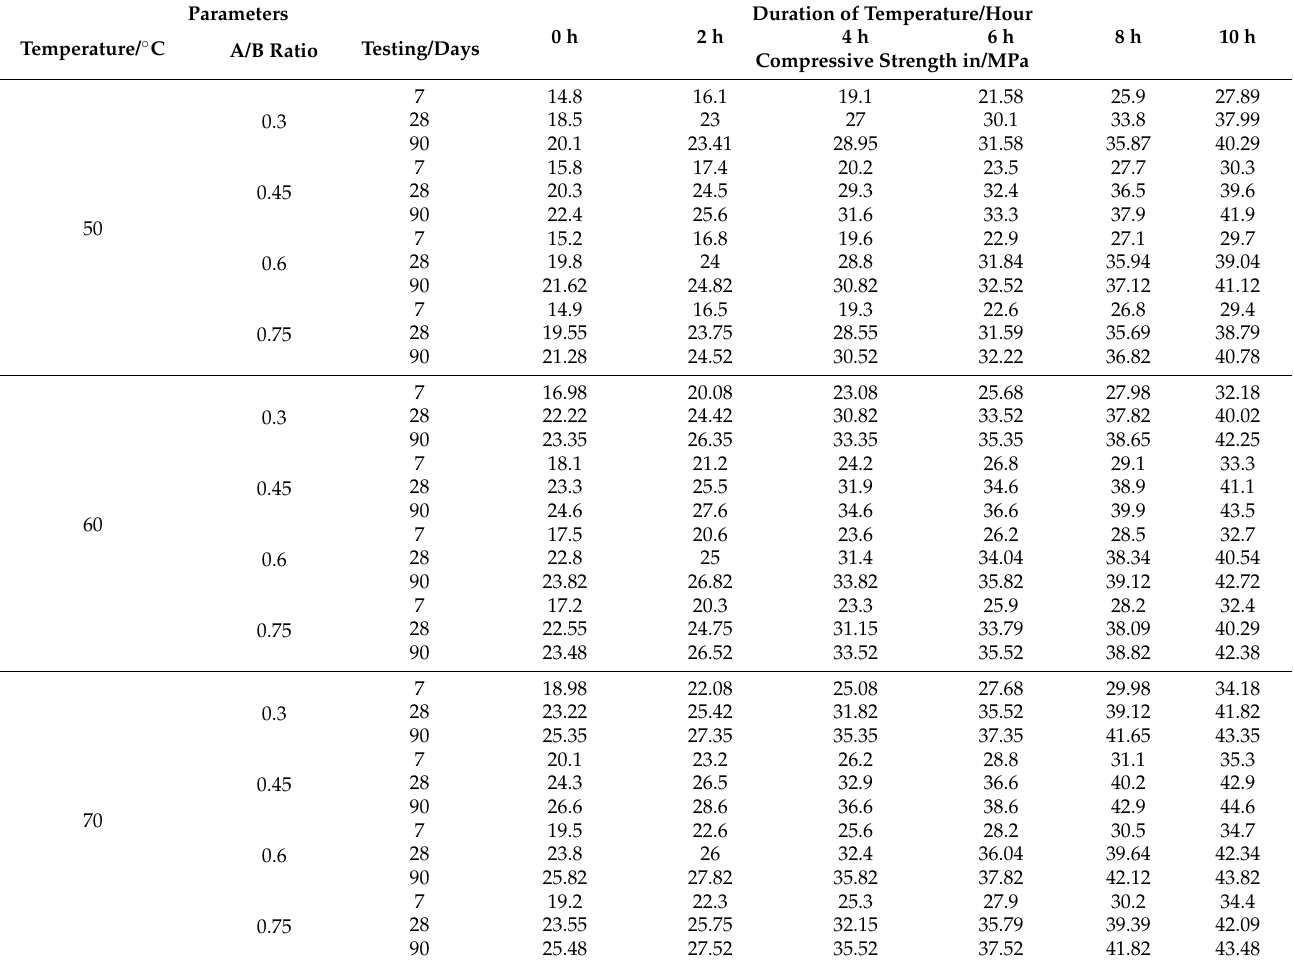
Table 4. DT results for various temperature and A/B